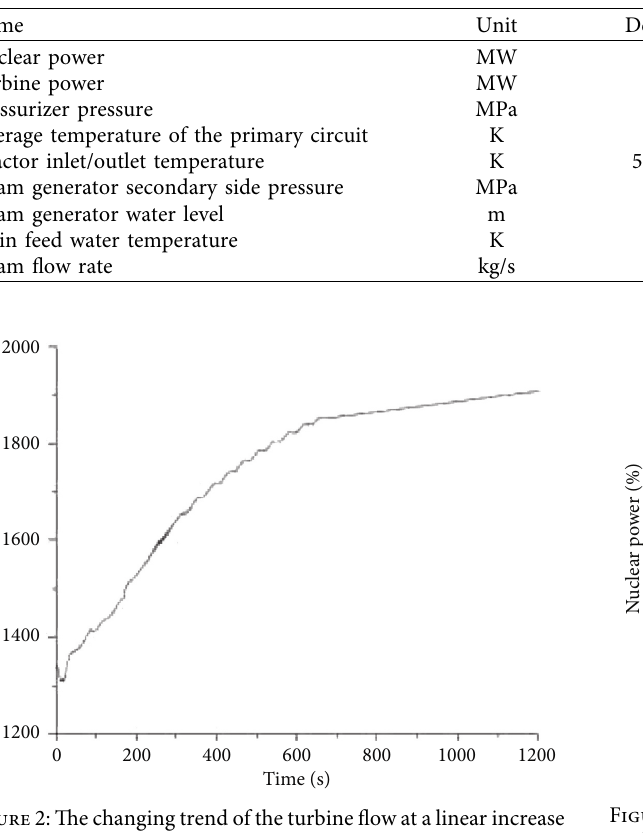
Figure 1: The node diagram of the primary circuit of a nuclear power plant system. Table 1: Comparison between the predicted and designed values of the main state parameters of the reactor.